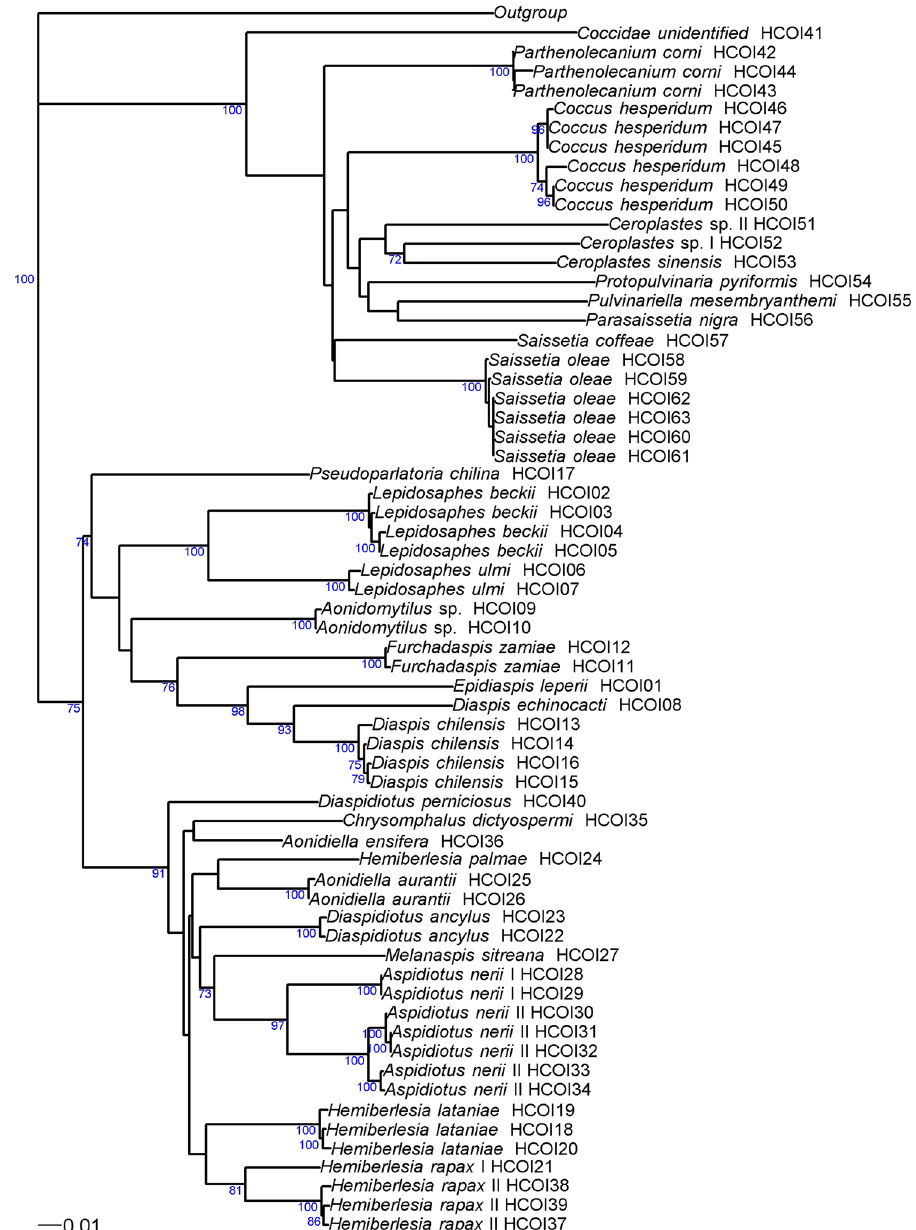
Figure 1. Phylogenetic relationships between 63 haplotypes of Coccidae and Diaspididae based on COI sequences analyzed by neighbor-joining, with the K2P distance model, and Pseudococcus viburni (Hemiptera: Pseudococcidae) (GenBank accession: KJ530624) as the outgroup. Bootstrap values below 70% are not